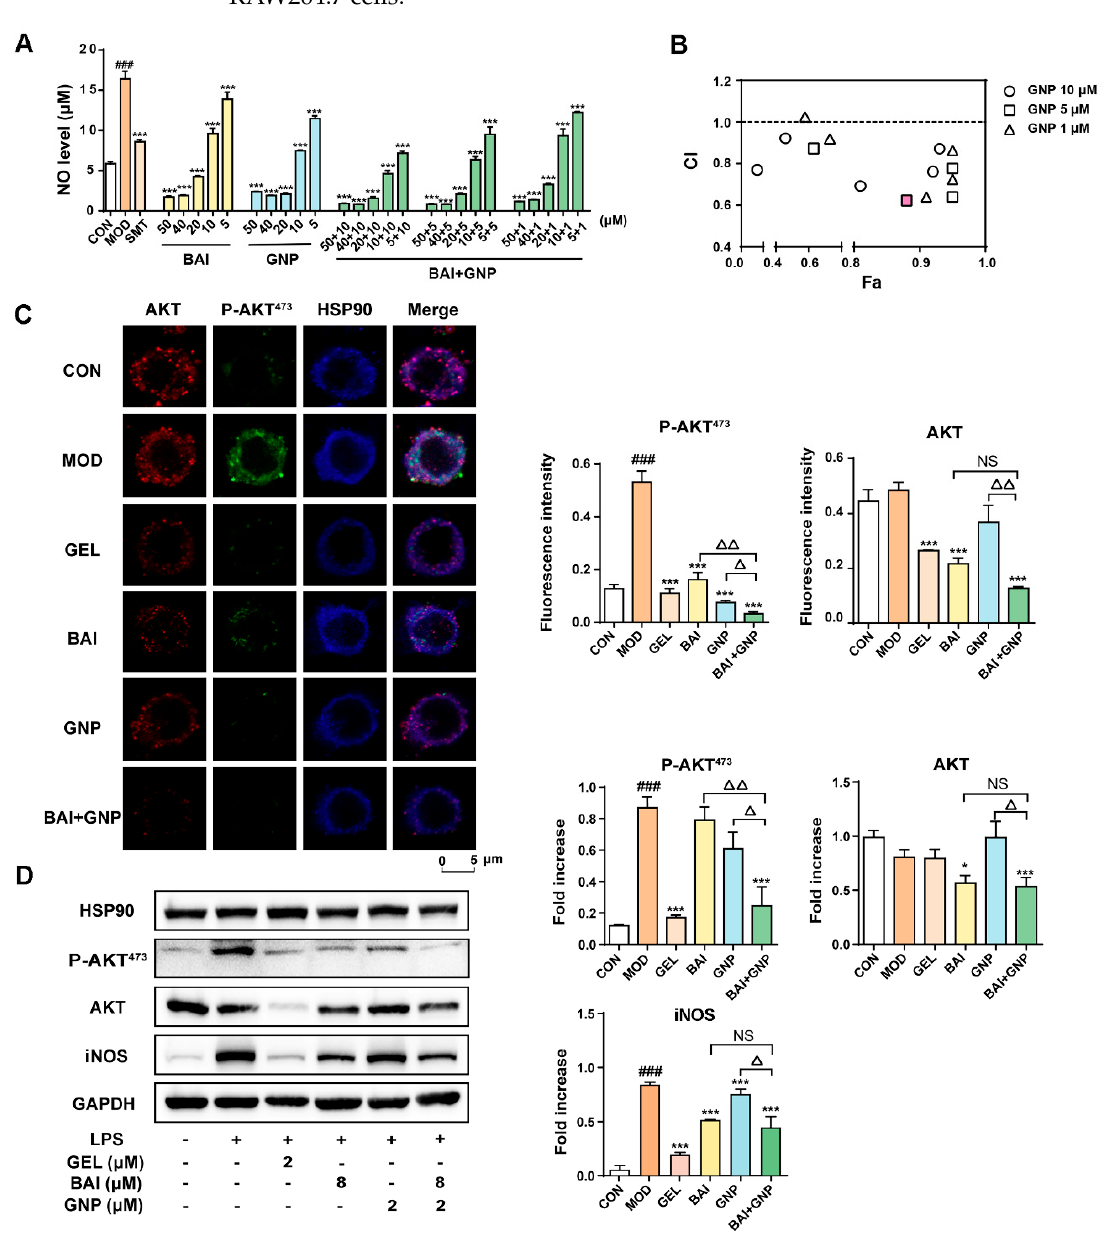
Figure 3. The combined anti-inflammatory effect of BAI and GNP in LPS-induced RAW264.7 cells. ( A ) Inhibitory levels of BAI and GNP on nitric oxide production in LPS-induced RAW264.7 cells. ( B ) Combination index between BAI and GNP. ( C ) The representa- tive image of the combined effect of BAI and GNP on P-AKT and AKT detected using co-localization. ( D ) Expression of P-AKT 473 , AKT, and iNOS attenuated by the combination of BAI and GNP ( n = 3). Each bar represents the mean ± SD. ### p < 0.001 vs. CON group; * p < 0.05 and *** p < 0.001 vs. MOD group; △ p < 0.05 and △△ p < 0.01 vs. BAI + GNP group. BAI, baicalein; CON, control; GNP, genipin; GEL, geldanamycin; HSP90, heat shock protein 90; INOS, inducible nitric oxide synthase; LPS, lipopolysaccharide; MOD, model; NS, no significance; SMT, S-methylisothiourea sulfate.